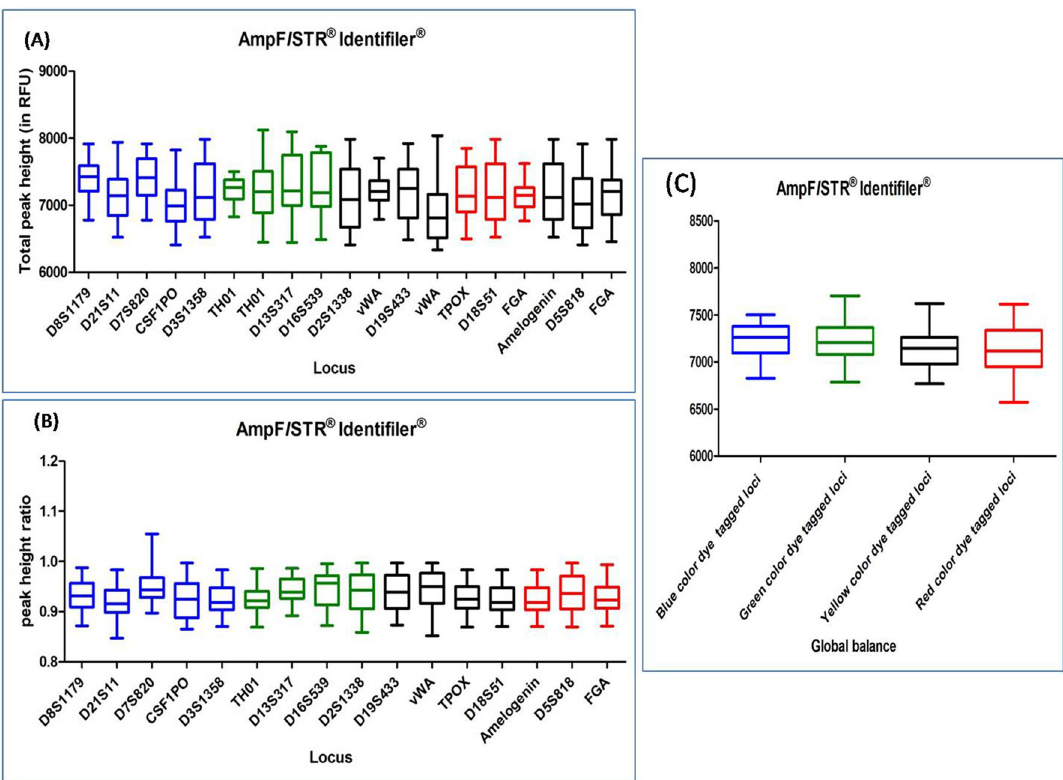
Figure 2. Quality assessment of DNA profile by Dunn’s multiple comparison test for the AMPF L STR IDENTIFILER PCR AMPLIFICATION KIT ( A ) Total peak height ( B ) Peak height ratio ( C ) Global